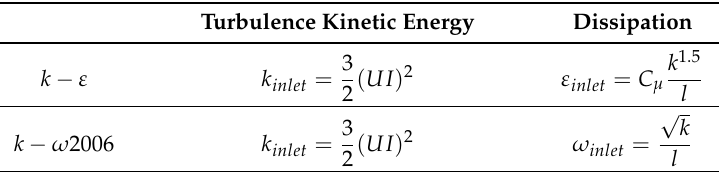
Table A1. Inlet boundary conditions for turbulent